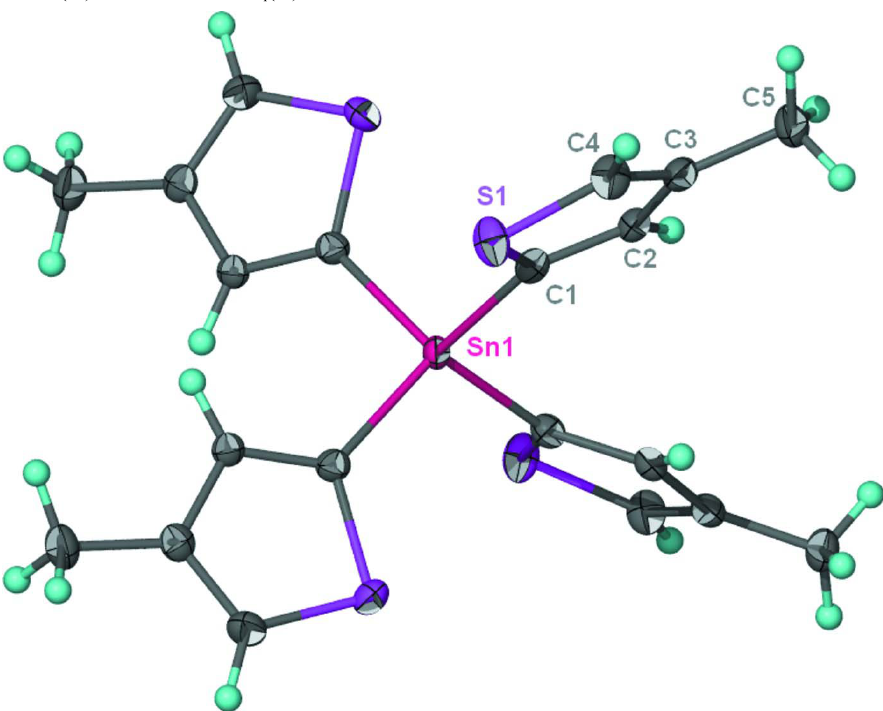
H S) ] at the 70% probability level. H atoms are drawn as spheres 5 5 4